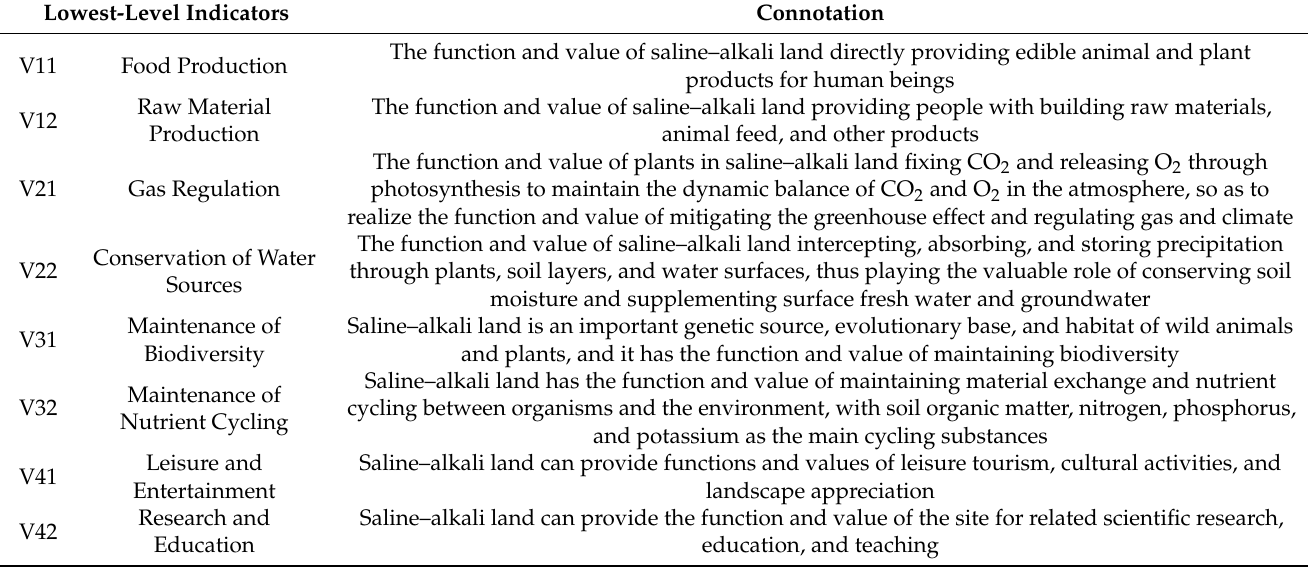
Table 2. Connotation definition of the ESV evaluation index